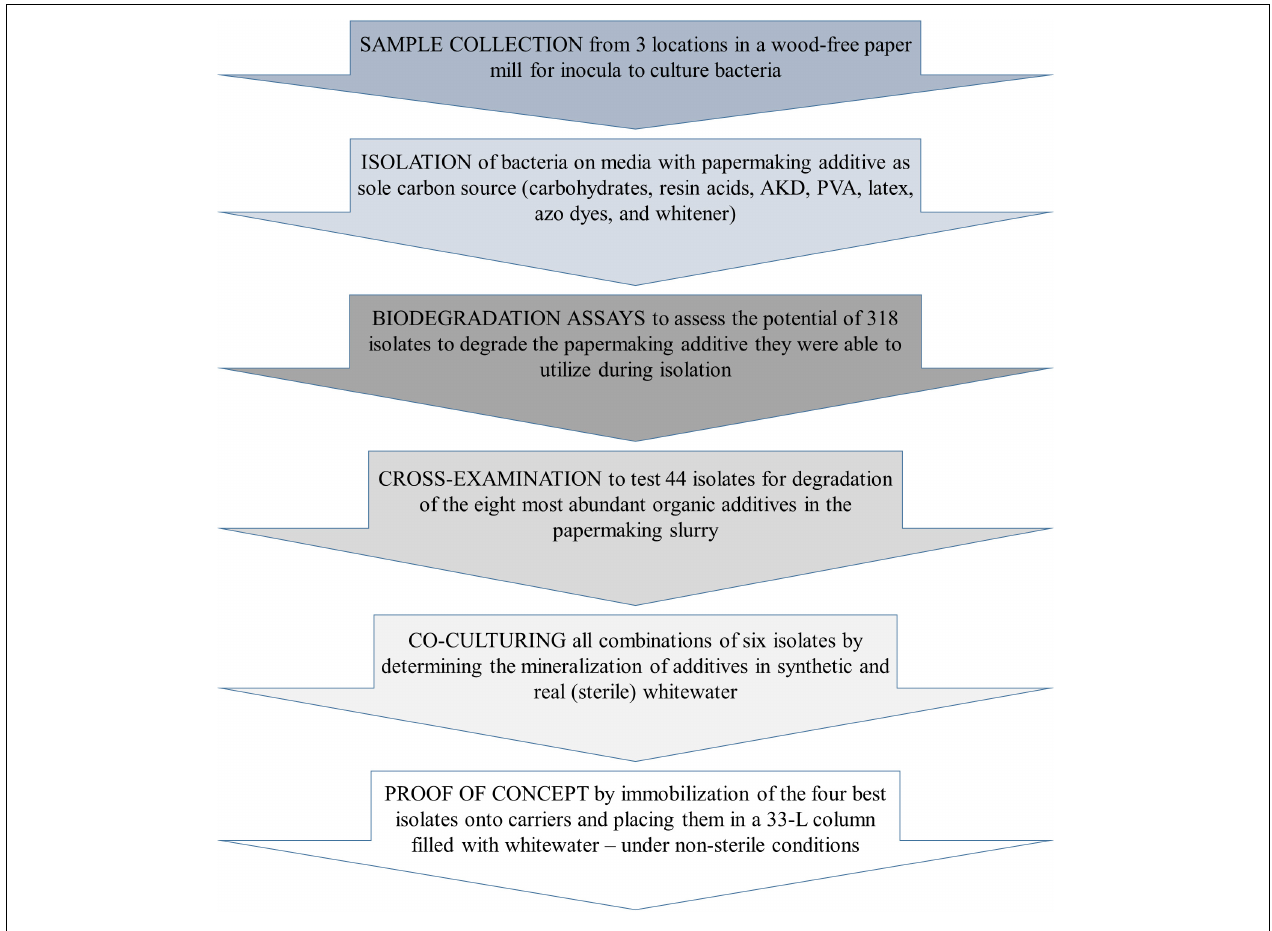
FIGURE 1 | Construction of a bacterial consortium with high potential for wood-free whitewater